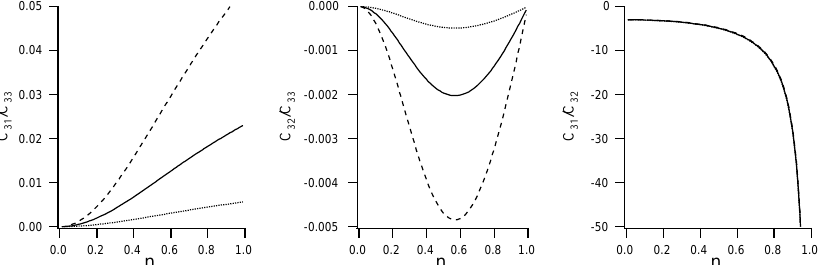
FIG. 3. The relative oscillation amplitude in dispersion oscillation cases. Three different j have been considered, i.e., j (cid:1) 0.075 (dotted line), j (cid:1) 0.15 (solid line), and j (cid:1) 0.225 (broken